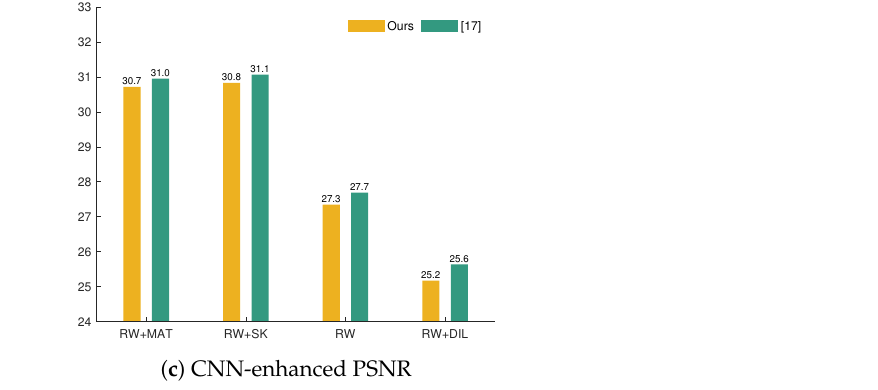
Figure 13. Bar plots showing the overall performance of three CNN-based mage quality metrics (IQMs) for groups of damage. These metrics measure the similarity of the feature maps given by the activations of AlexNet (pretrained on ImageNet) for the ground-truth test images and images inpainted by our approach and [17]. The overall metrics are aggregated as the geometric mean of the result at each convolutional